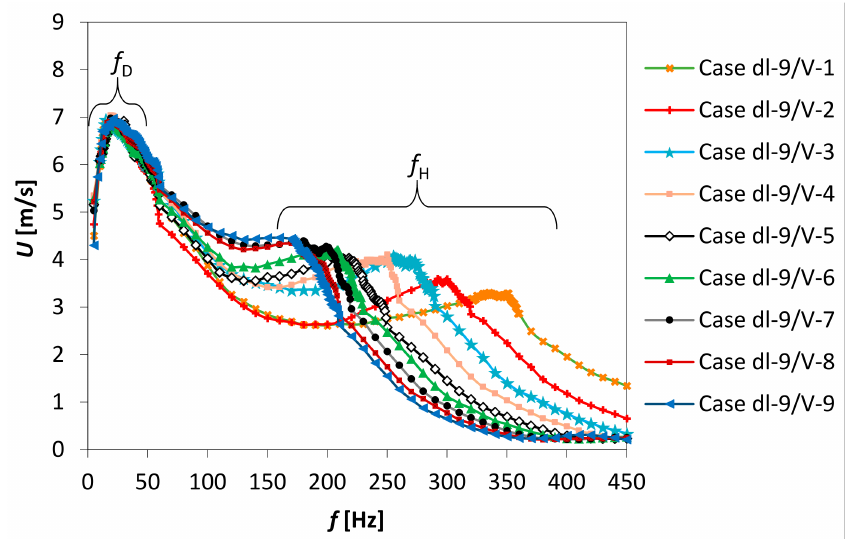
Figure 5. Synthetic jet momentum velocity as a function of excitation frequency for E = 3 V for various cavity depth.